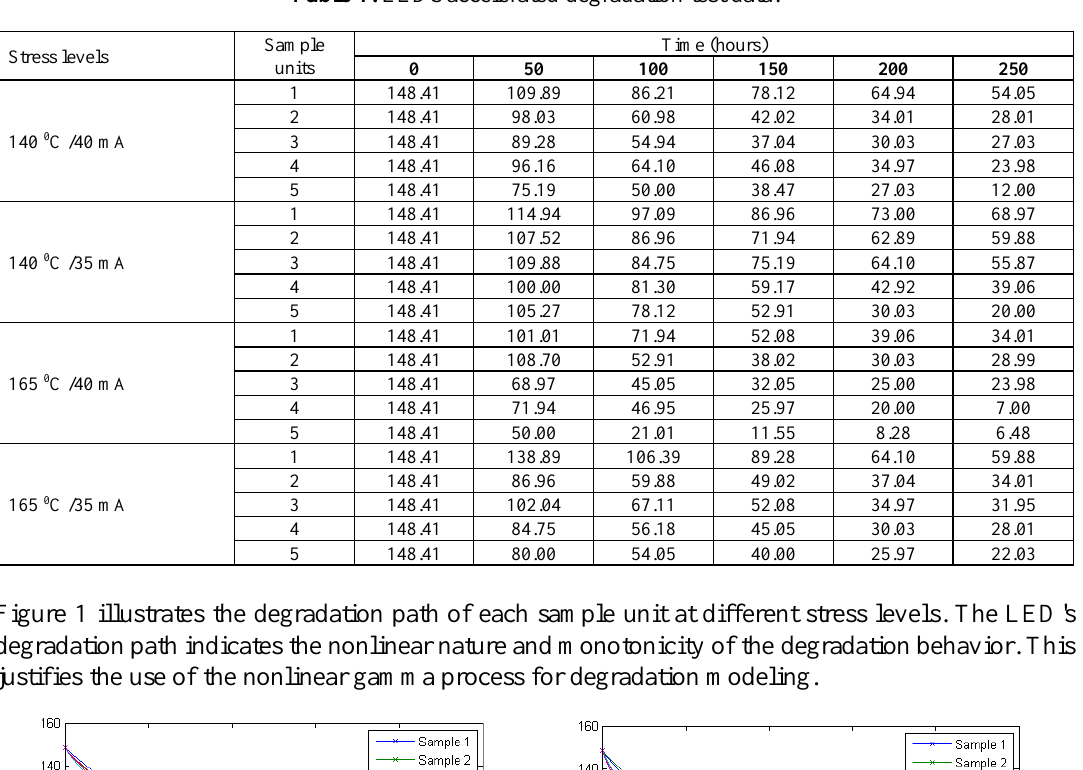
Table 1. LEDs accelerated degradation test data.